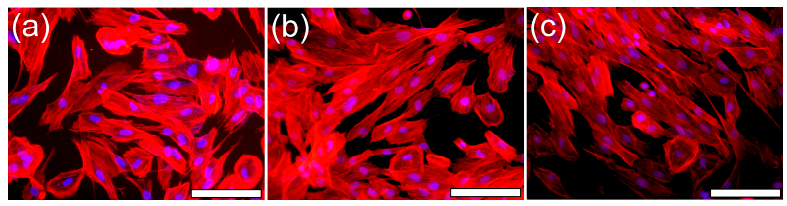
Figure 13. Epi-fluorescence microscopy images revealing the morphology of Hs27 fibroblast cells grown on: ( a ) bare Si substrate and ( b ) S2 and ( c ) S4 type films. The actin cytoskeleton was stained with phalloidin-AlexaFluor596 (red), whilst cell nuclei were counterstained with DAPI (blue). Objective: 20X. Magnification bar: 50 μ m.